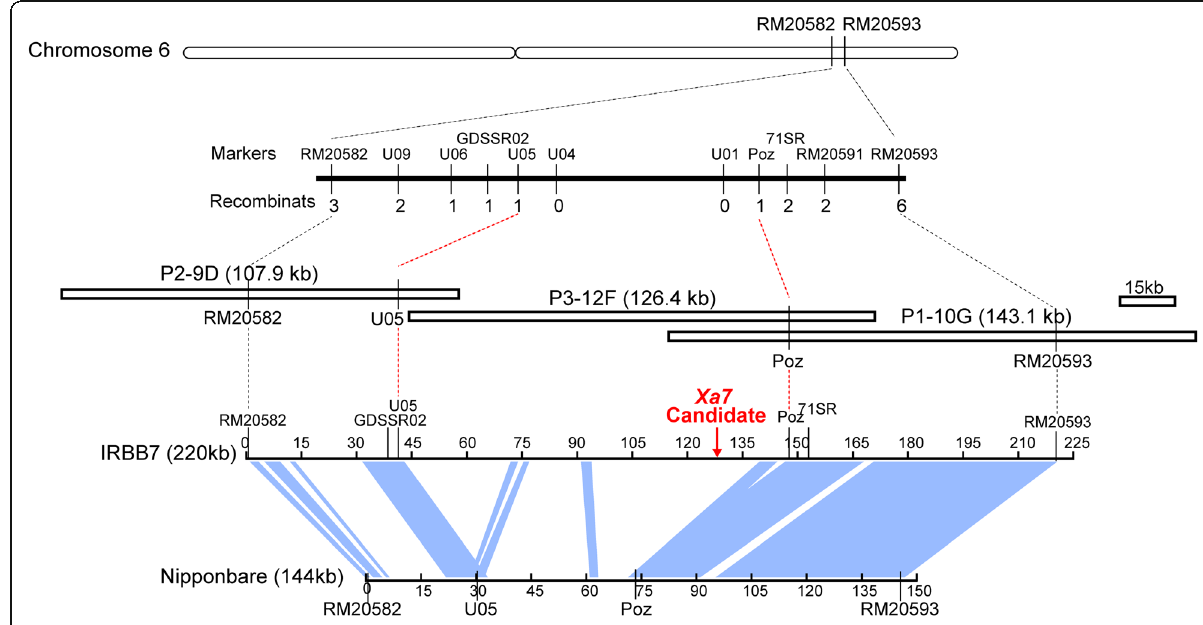
Fig. 1 Fine mapping of Xa7 . The vertical lines represent the sites of key markers in the physical map. The IRBB7 BAC contigs are represented by overlapping unfilled rectangles. The light blue shading indicates collinear regions of the IRBB7 vs. Nipponbare genome. The region between the red dotted lines is the mapped Xa7 region, which is flanked by the markers U05 and